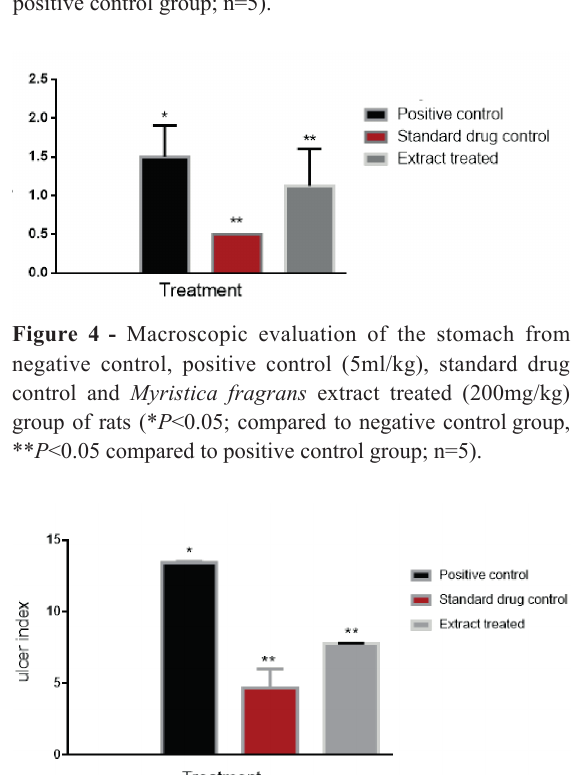
Figure 3 - Determination of total acidity of gastric contents from negative control, positive control, standard drug control and Myristica fragrans extract treated group of rats (*P<0.05; compared to negative control group, **P<0.05 compared to positive control group; n=5).